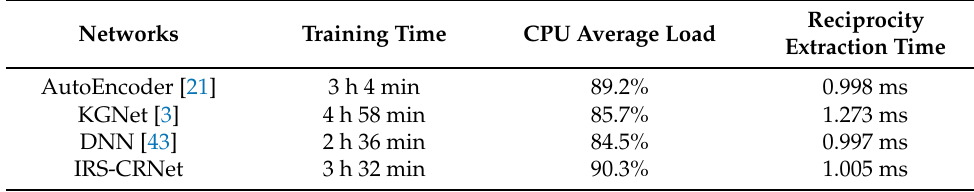
Table 7. Computational overhead of different